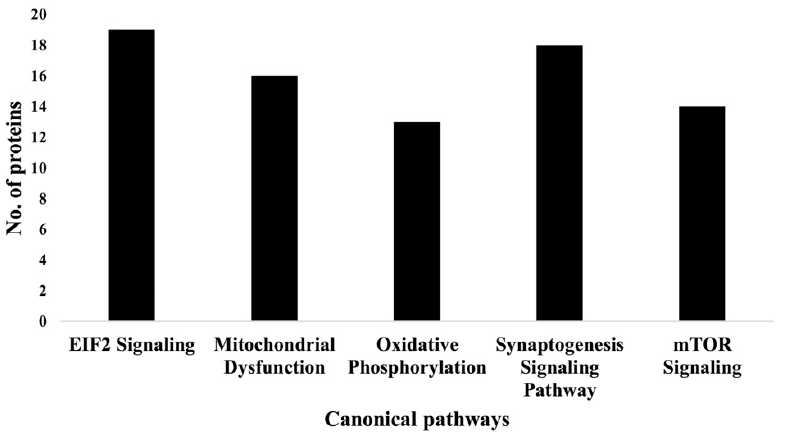
Figure 4. Graph representation of the numbers of molecules identified in the top 5 canonical pathways affected by TAC treatment. Table 5. Top 5 networks associated with TAC/PL vs. TAC treatment. Network